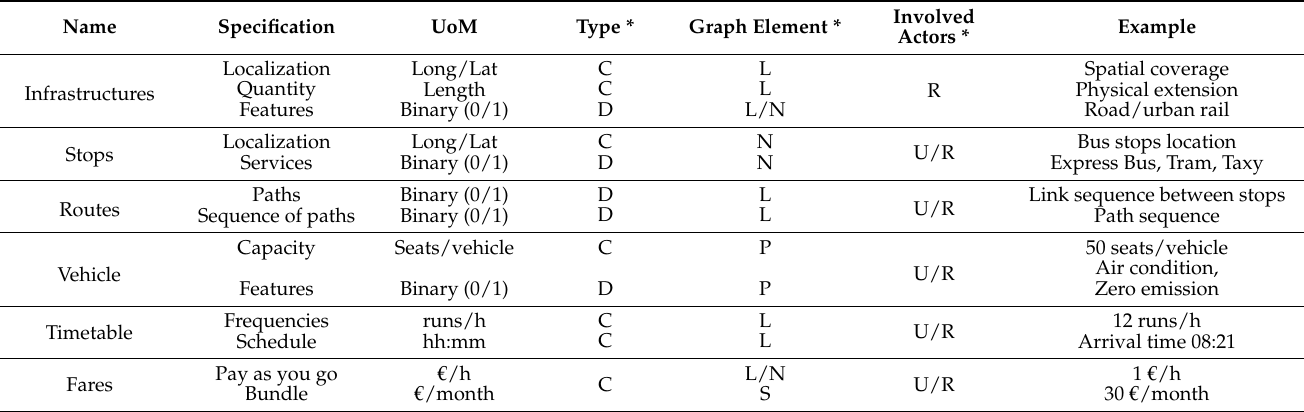
Table 3. Main control variables: collective services.